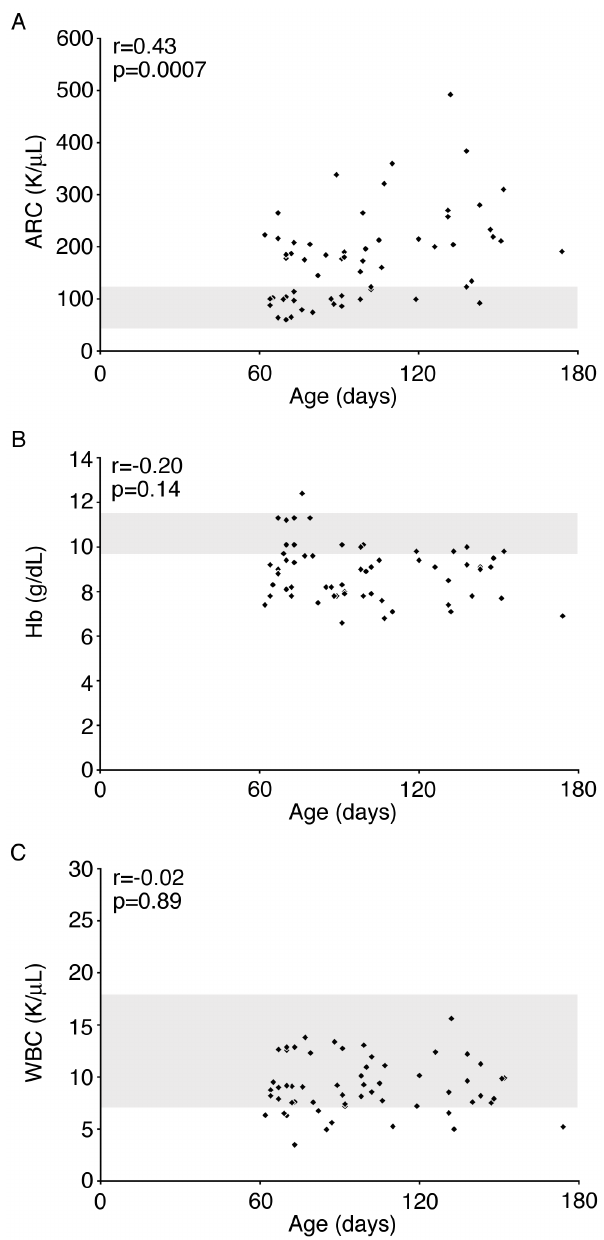
Figure 1. Absolute Reticulocyte Counts, Hemoglobin and White Blood Cell distribution during early infancy in a contemporary, observational SCA cohort. A. Distribution of absolute reticulocyte count values among 59 subjects ages 60–180 days. B–C. Hemoglobin and White blood cell count distribution in the same cohort. Shaded area represents the normal range for a 3-month- old healthy infant. [19] Age in days is shown on the x-axis in each panel. Correlation coefficients (r) and p- values are shown in each panel. ARC, Absolute Reticulocyte Count; Hb, hemoglobin; WBC, White Blood Cell